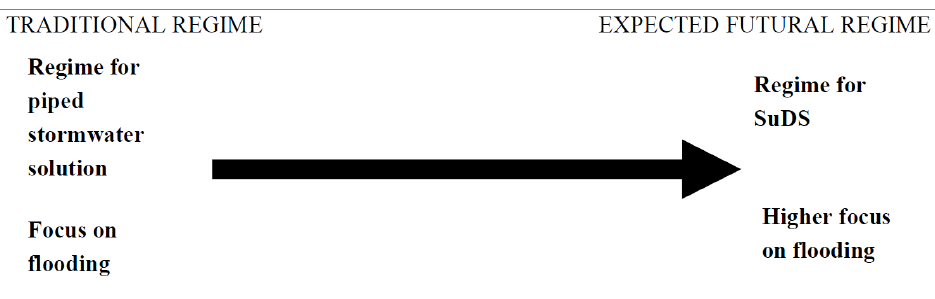
Figure 1. Transition line toward a sustainable urban drainage system (SuDS)-focused